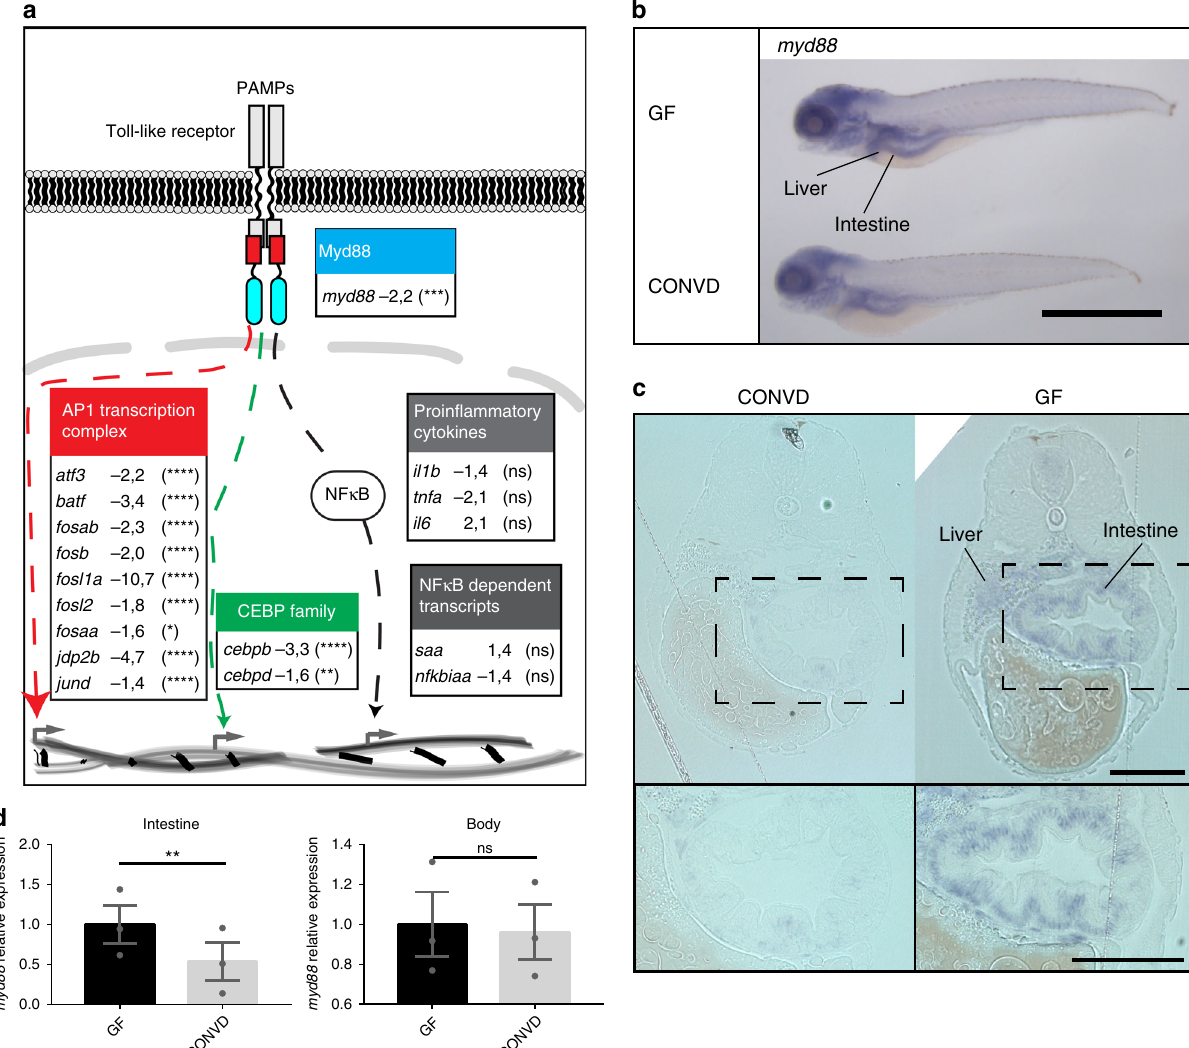
Fig. 2 Microbes transcriptionally suppress Myd88 and downstream signaling components. a Graphic representation of the canonical TLR stimulated Myd88 dependent transcriptional signaling though the AP1 transcription complex (red), the CCAAT/enhancer binding protein family (green) or the NF- κ B nuclear translocation (gray), along with associated gene names and fold-change values in the conventionalized group relative to germ-free. Nine transcription factors of the AP1 transcription complex and two members of the CCAAT/enhancer binding protein (C/EBP) family exhibited signi fi cant transcriptional suppression upon colonization. The activation of NF- κ B is not readily observable by transcriptomics, however neither the NF- κ B dependent transcripts serum amyloid A ( saa ) or NF- κ B inhibitor Alpha a ( nfkbiaa ) or the proin fl ammatory cytokines normally associated with NF- κ B activation